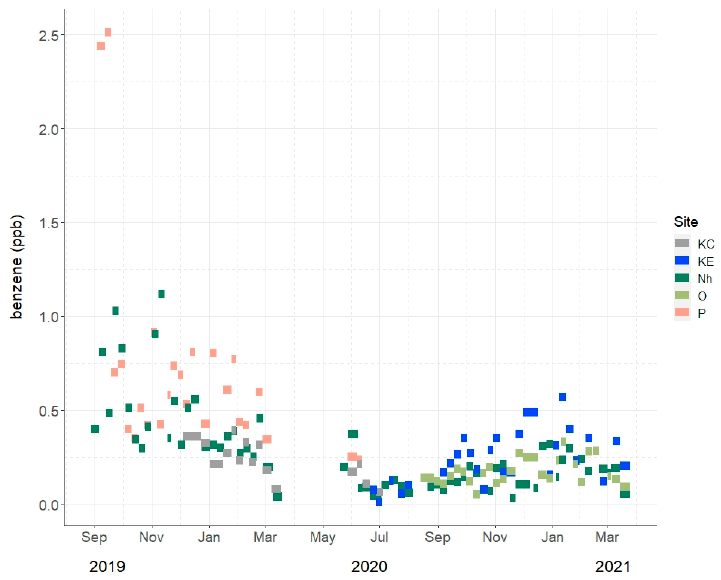
Figure 5. Benzene time series for all sites. Each segment’s width represents the period of deploy- ment.